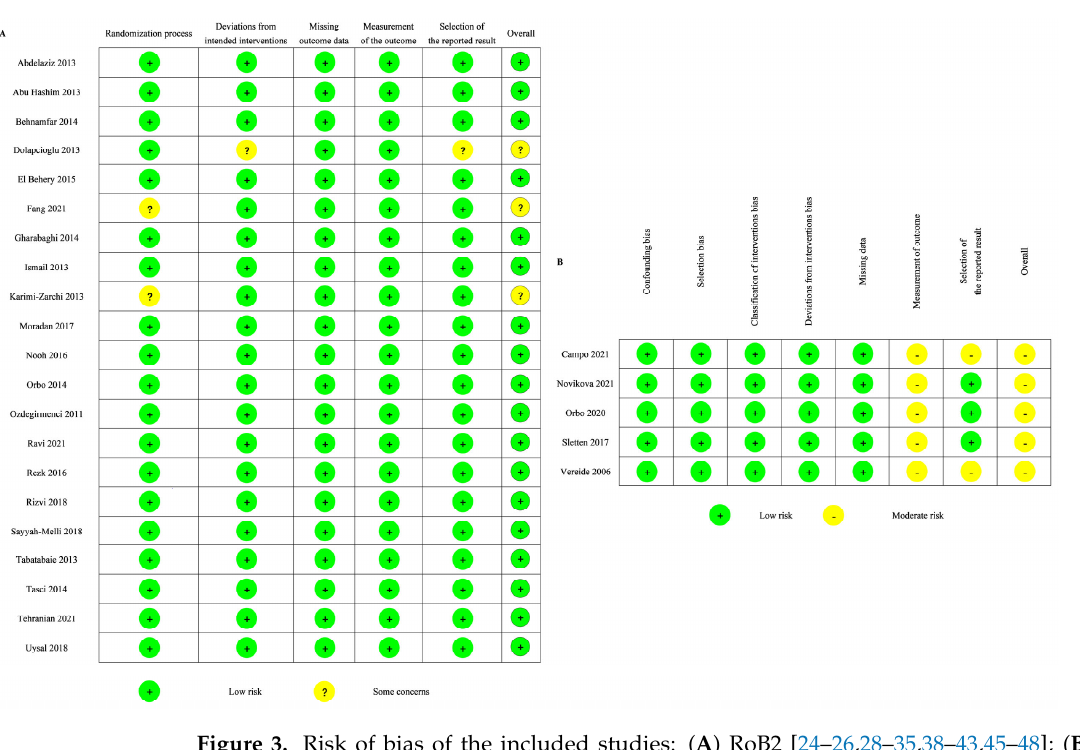
Figure 3. Risk of bias of the included studies: ( A ) RoB2 [24–26,28–35,38–43,45–48]; ( B ) ROBIN ‐ I [27,36,37,44,49].